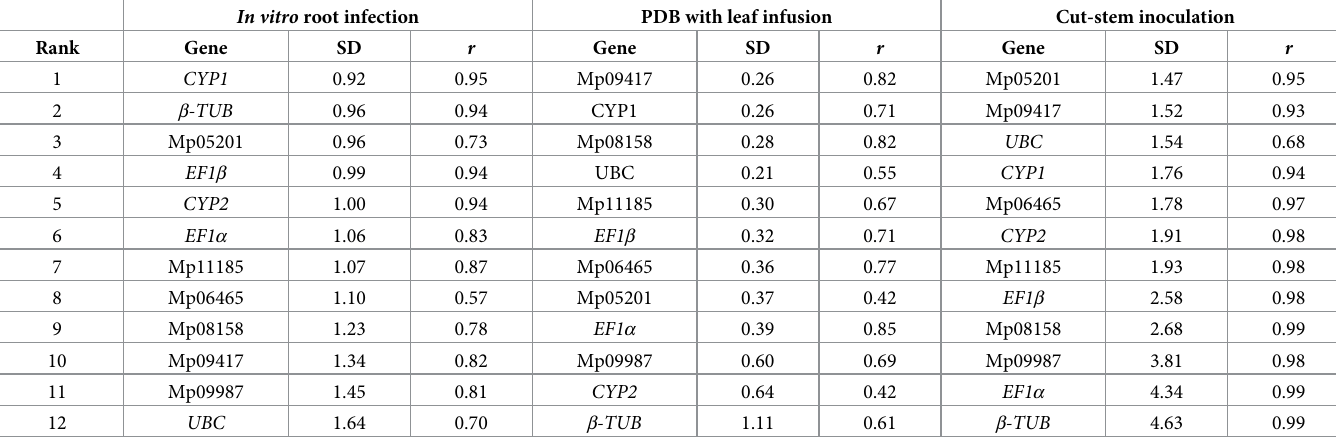
Table 3. Expression stability of candidate reference genes as determined by